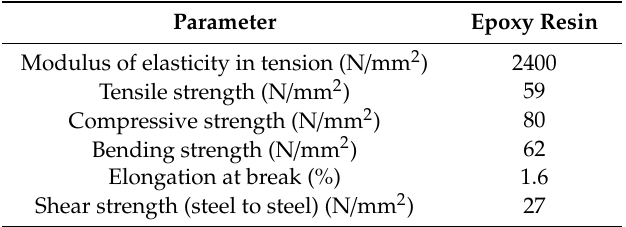
Table 5. Material properties of bonding agent from the manufacturers.